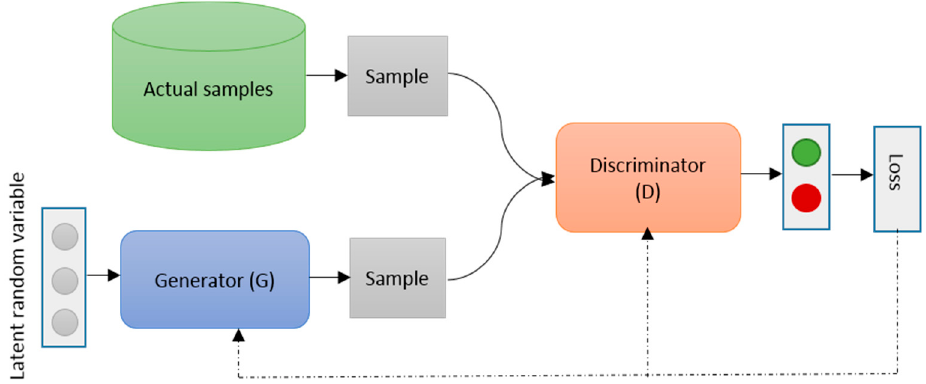
Figure 38. Conceptual diagram for Generative Adversarial Networks (GAN).